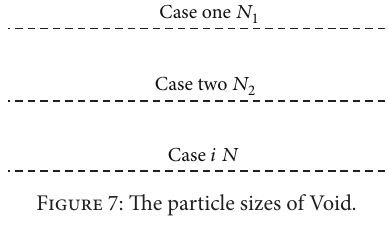
Figure 7: The particle sizes of